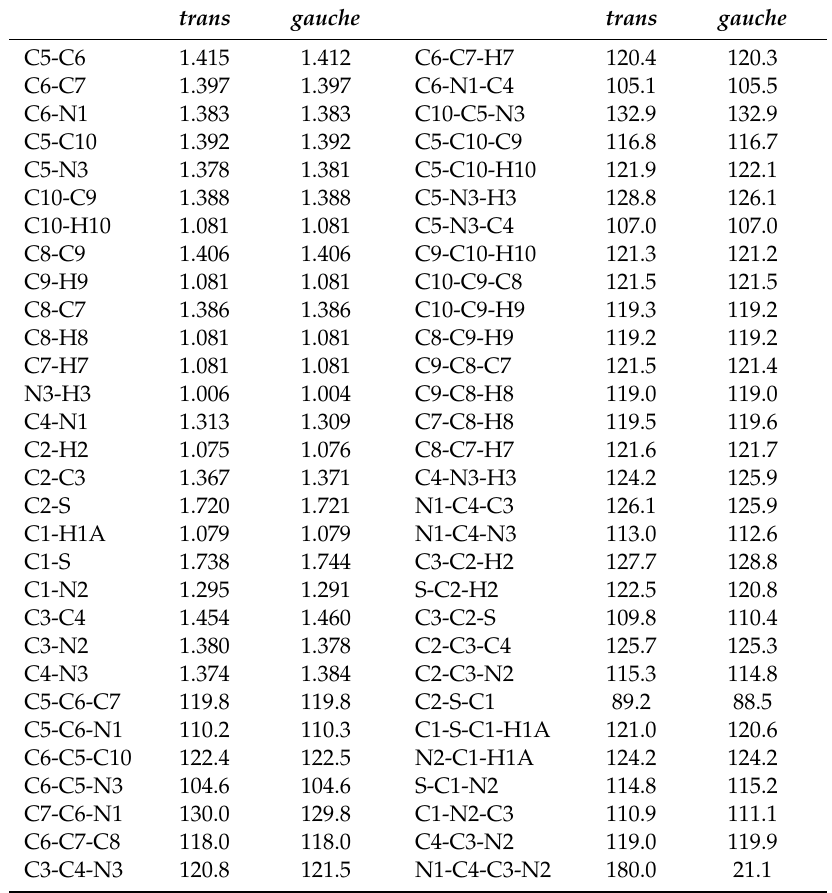
Figure 1. Conformers of thiabendazole ( trans and gauche ) and transition state ( cis ) between the two equivalent-by-symmetry gauche forms, as calculated at the B3LYP/6-311++G(2d,2p) level of theory. Energy differences relative to the trans conformer are shown in parentheses. See Scheme 1 for atom numbering. Table 1. B3LYP/6-311++G(2d,2p) optimized geometric parameters for TBZ conformers a .